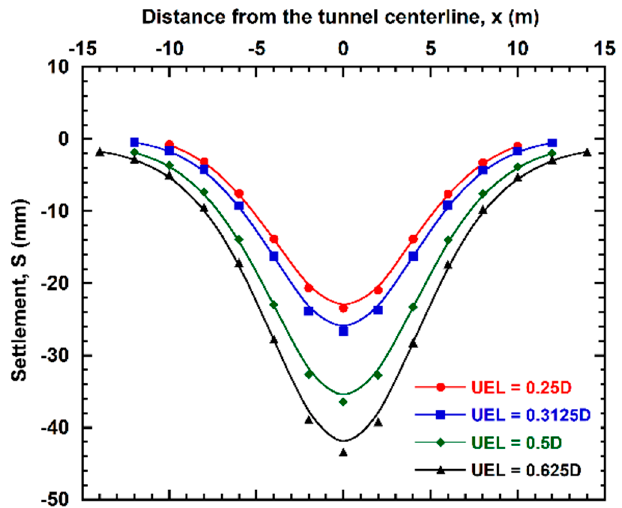
Figure 5. Effect of unsupported excavation length (UEL) on tunnelling induced ground settlement.